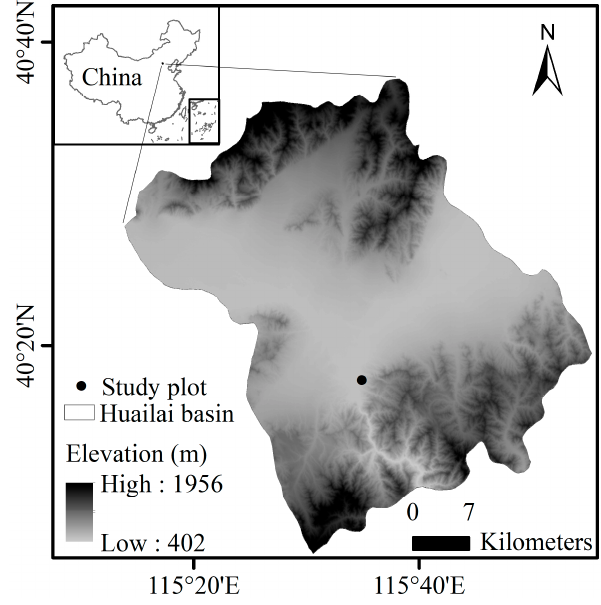
Figure 1. The location of the study site and study plot.